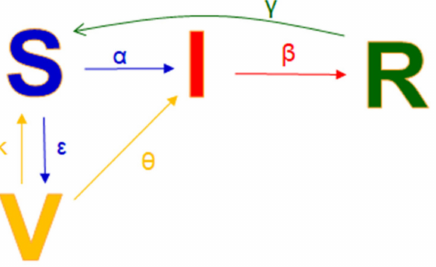
Figure 4. Schematic representation of the CSIRV